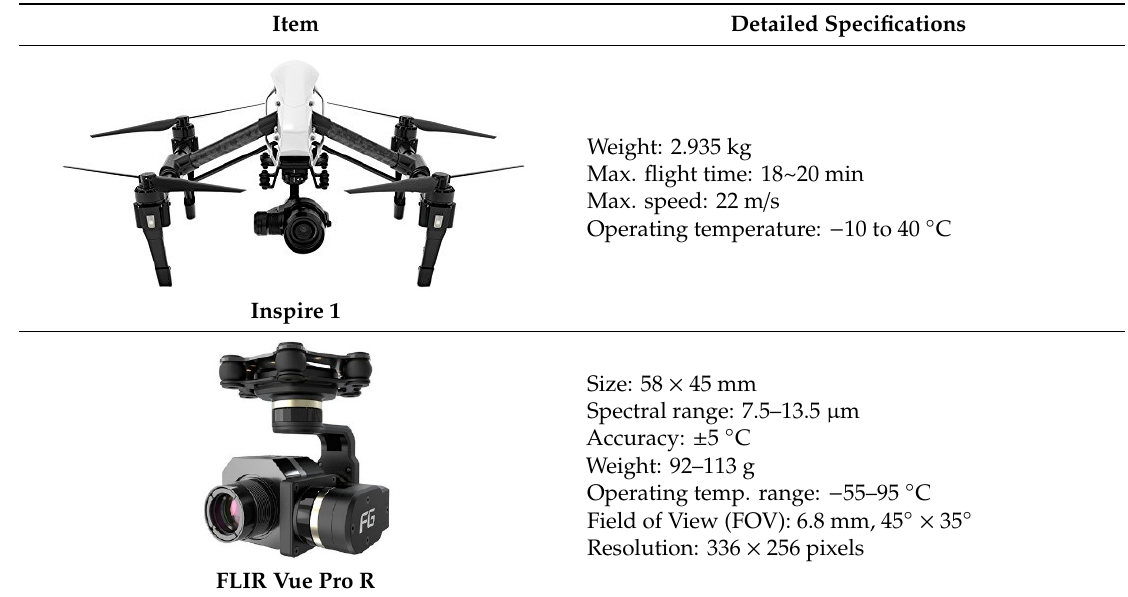
Table 1. Detailed specifications of Inspire 1 and FLIR Vue Pro R. Item Detailed Specifications